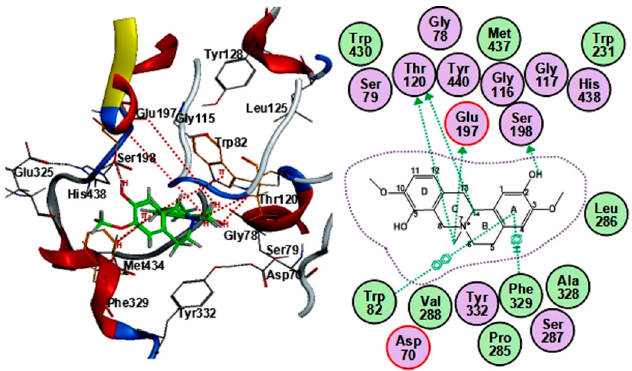
Figure 7. The binding mode of cyclanoline with BChE (PDB code: 4BDS). The 3D (left) and 2D (right) interaction of cyclanoline with BChE. The ligand is shown in green in the 3D interaction diagram. The dotted arrow from the structure to amino-acid residues represents the sidechain donor. The arene symbol represents π bond interactions with other chemical groups.